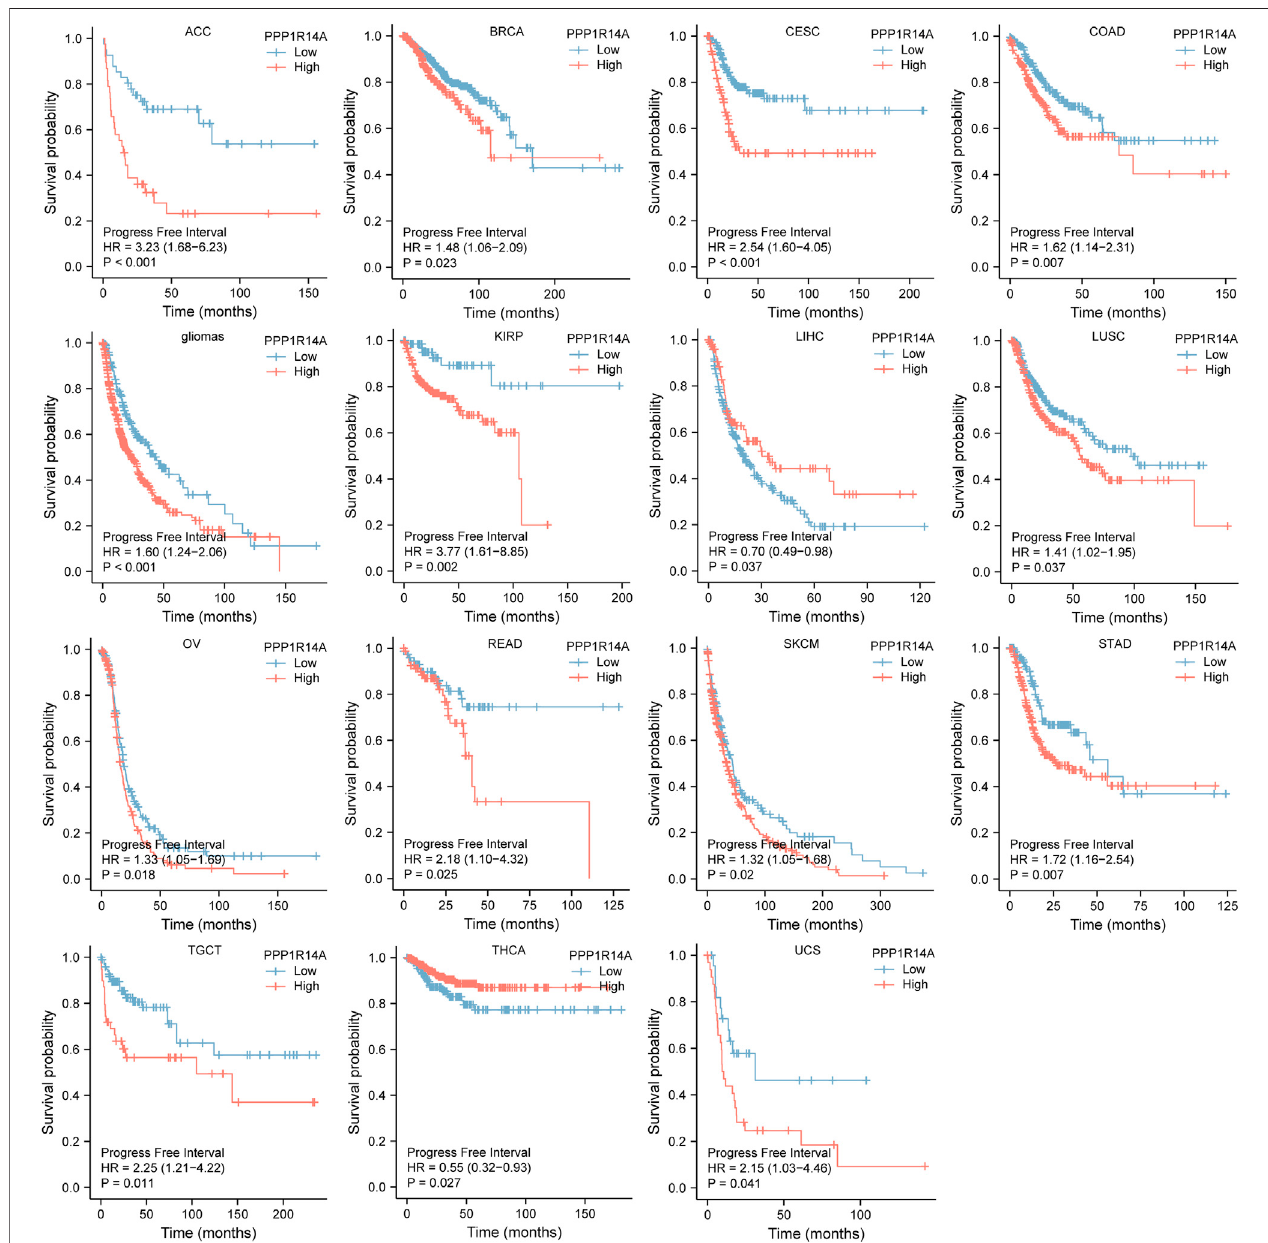
FIGURE 6 | Association between the PPP1R14A expression and the PFI of cancer patients. Kaplan – Meier survival curves for patients strati fi ed by the different expressions of PPP1R14A in ACC, BRCA, CESC, COAD, gliomas, KIRP, LIHC, LUSC, OV, READ, SKCM, STAD, TGCT, THCA, and UCS.